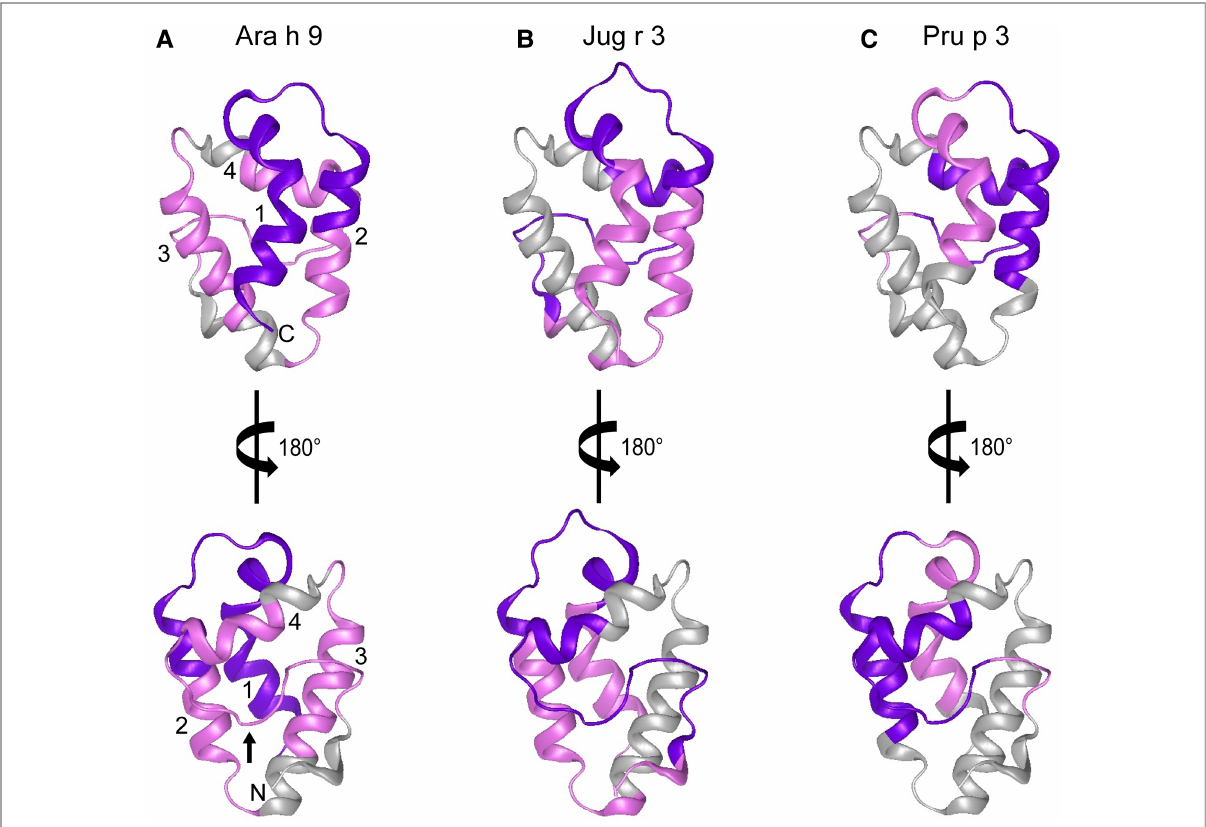
FIGURE 5 Predicted 3D structures of Ara h 9, Jug r 3, and Pru p 3. The frontal and the 180° rotated views of the predicted 3D structures of ( A ) Ara h 9, ( B ) Jug r 3, and ( C ) Pru p 3 using the SWISS-MODEL Protein Modeling Server (29) and PDB: 2B5S [rPru p 3.0102 (9)] as a model template. N-terminus and C- terminus are indicated in panel A with N and C, respectively. Numbers 1 – 4 in panel A are representative of the four major α -helices in LTPs. The small black arrow in panel A indicates the C-terminal coil. Major IgE reactive regions identi fi ed by US sera are highlighted in pink (median SNR ≥ 3 and <5) and purple (median SNR ≥